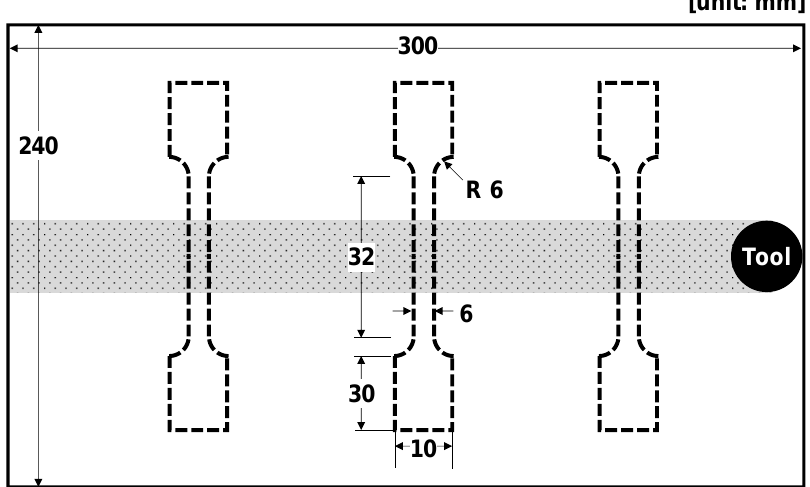
Figure 5. Pieces for uniaxial tensile tests.